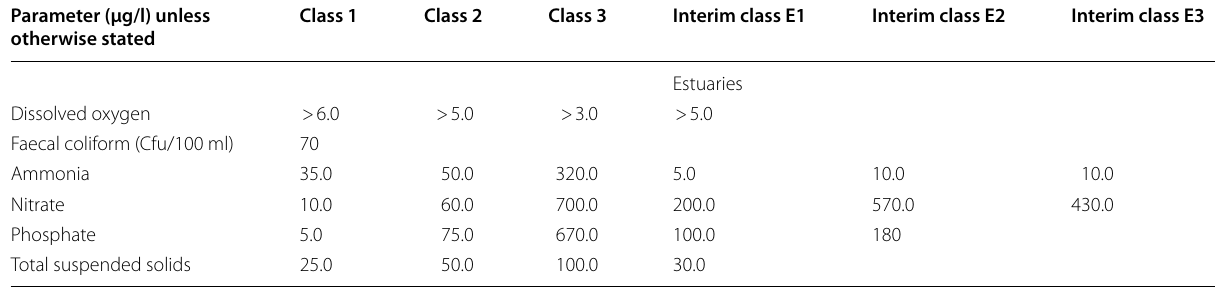
Table 4 Malaysian marine water quality standard (MMWQS) Parameter (μg/l) unless otherwise